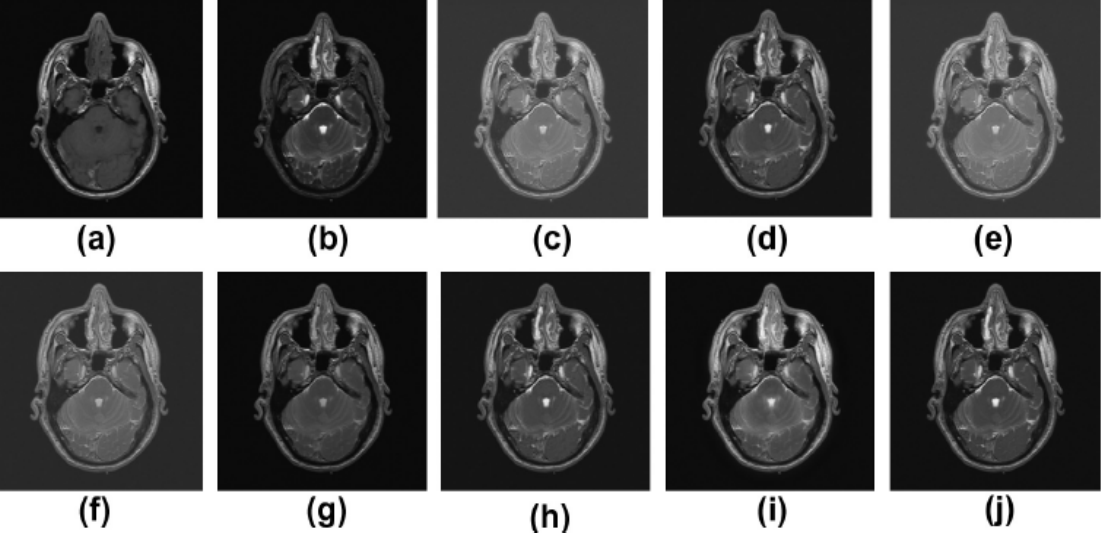
Figure 4. Results of multimodality medical image fusion; ( a ) input multimodality medical image 1; ( b ) input multimodality medical image 2; ( c ) Zhang et al. [12]; ( d ) Ramlal et al. [13]; ( e ) Dogra et al. [14]; ( f ) Ullah et al. [15]; ( g ) Huang et al. [16]; ( h ) Liu et al. [17]; ( i ) Mehta et al. [18]; ( j ) proposed method.